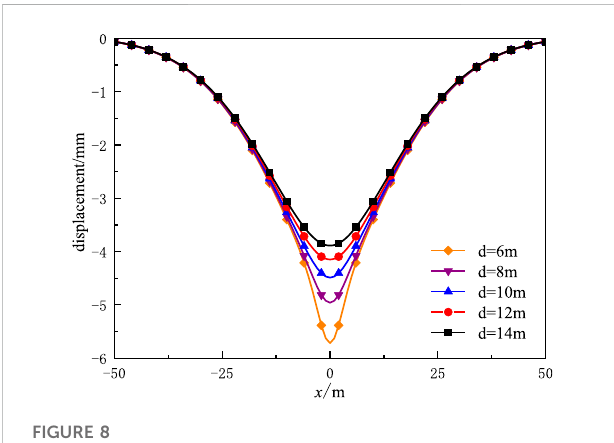
FIGURE 8 Curves of tunnel displacement under different spacing d.